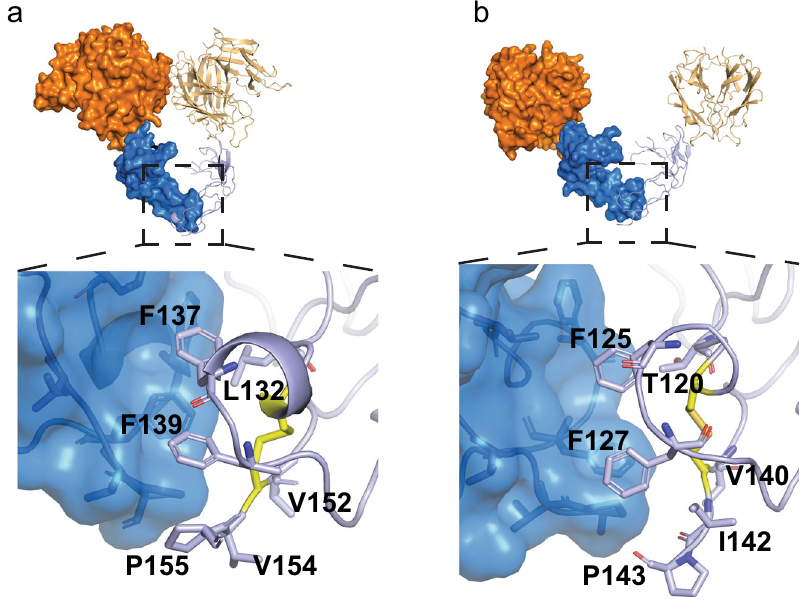
Fig. 3 C-terminal receptor – receptor interactions are conserved between human and mouse. Both human ( a ) and mouse ( b ) GITR show receptor – receptor interactions (shown in blue, GITRL in orange). Closer examination shows phenylalanine packing at a hydrophobic homodimeric interface in both human and mouse receptors.